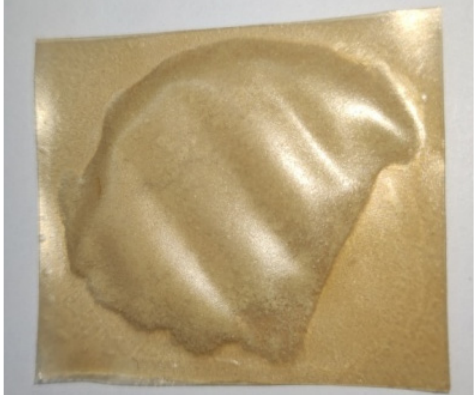
Figure 10. Application of β –glucanfilm with pomegranate juice for packaging powdered Vitamin